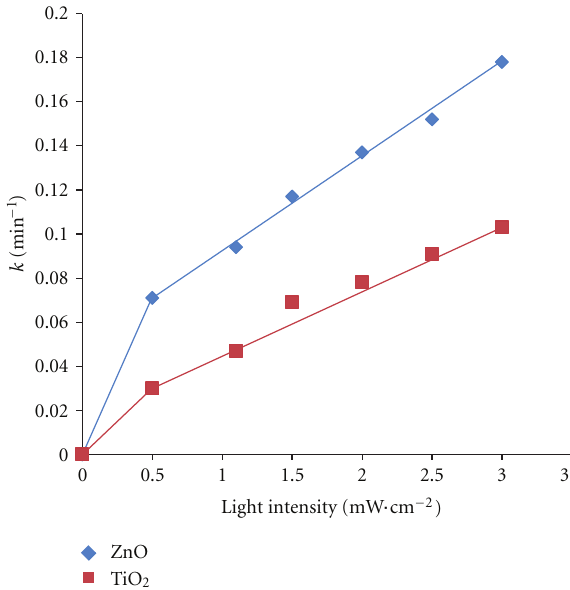
Figure 6: E ff ect of initial light intensity on the rate constant.